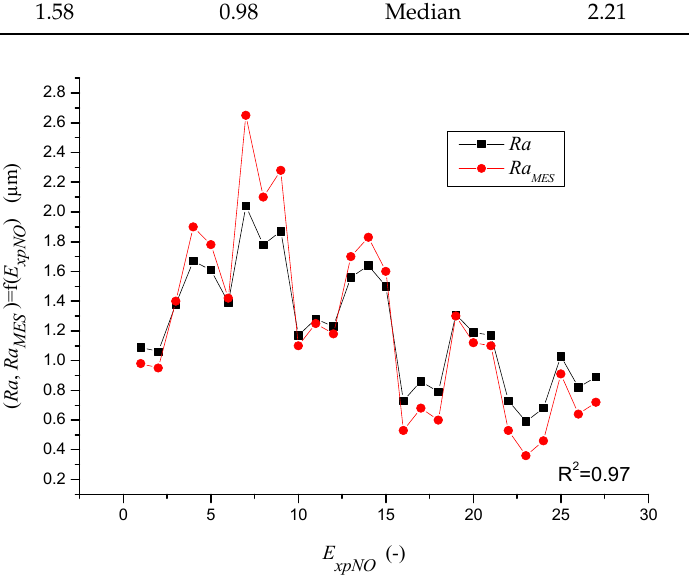
Figure 12. Comparison of parameters Ra , Ra MES = f ( E xpNO ), E xpNo = 1–27 (closeness of conformity R 2 =0.97).